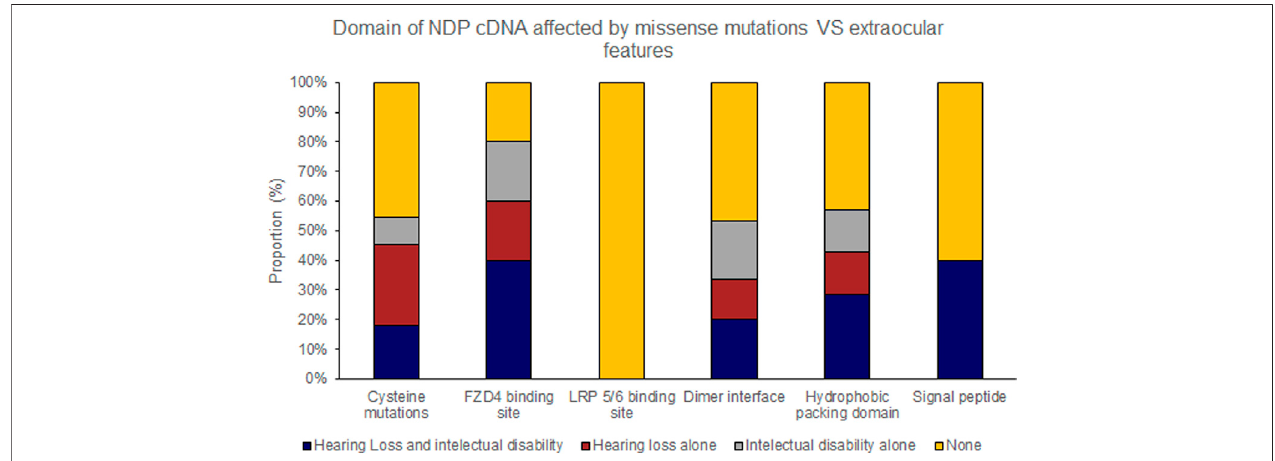
FIGURE 8 | Missense mutations within the NDP coding DNA were classi fi ed by the functional region of the NDP protein affected. The proportion of mutations of each type that caused extraocular features (hearing loss or intellectual disability) is